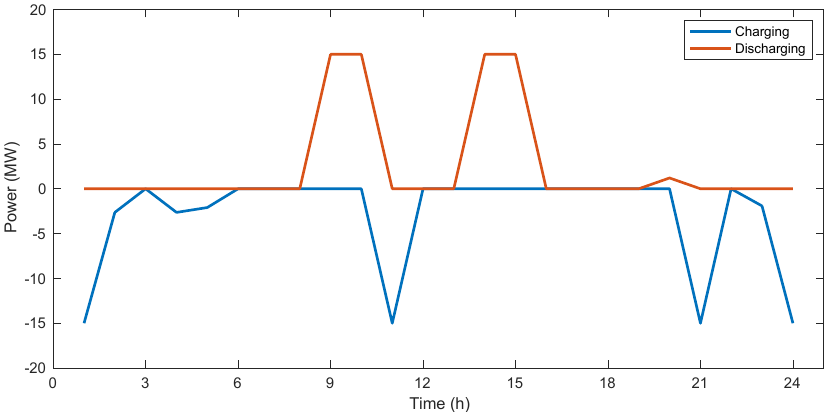
Figure 7. Operation results of electric energy storage.